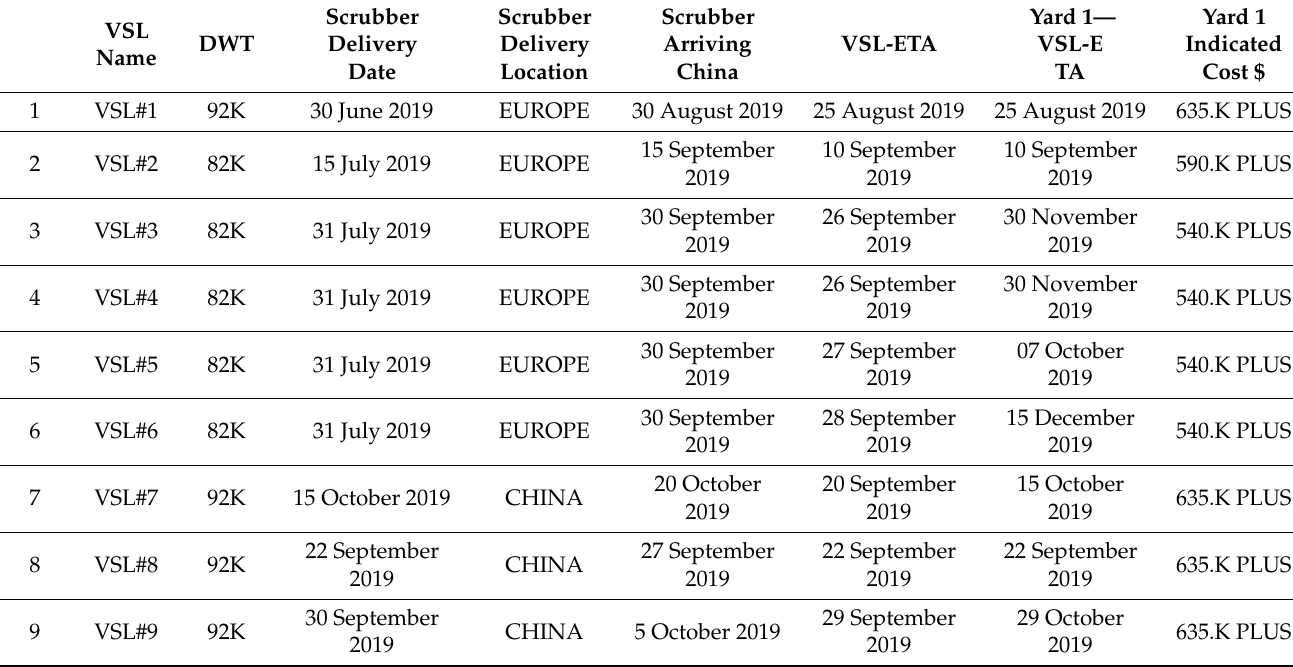
Table 10. Data for scrubber delivery date, Shipyard 1 vessel estimated time of arrival (ETA) and Shipyard 1 indicative cost for nine different vessels of a Greek maritime company. (Table was genuinely generated using data from ref.